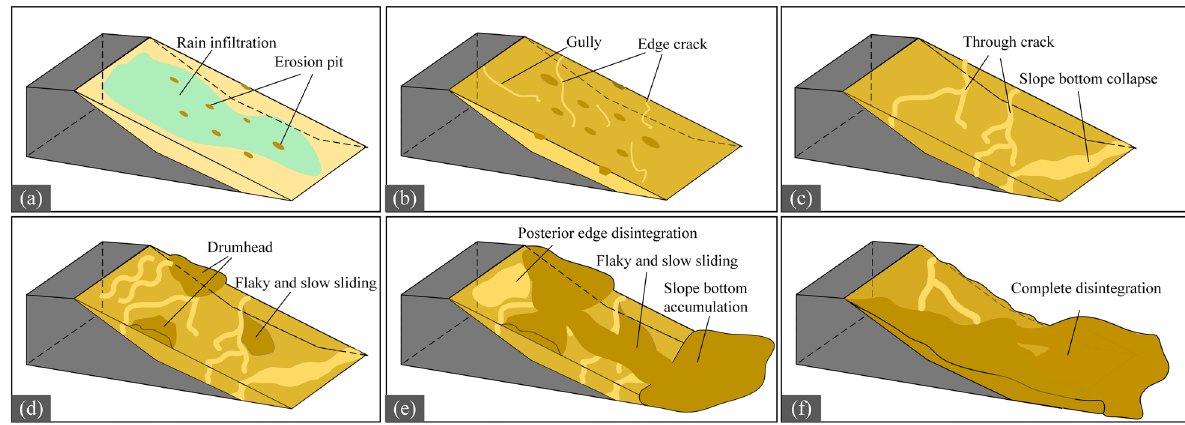
Fig. 17 Schematic diagram of failure process of completely weathered granite landslide under extreme